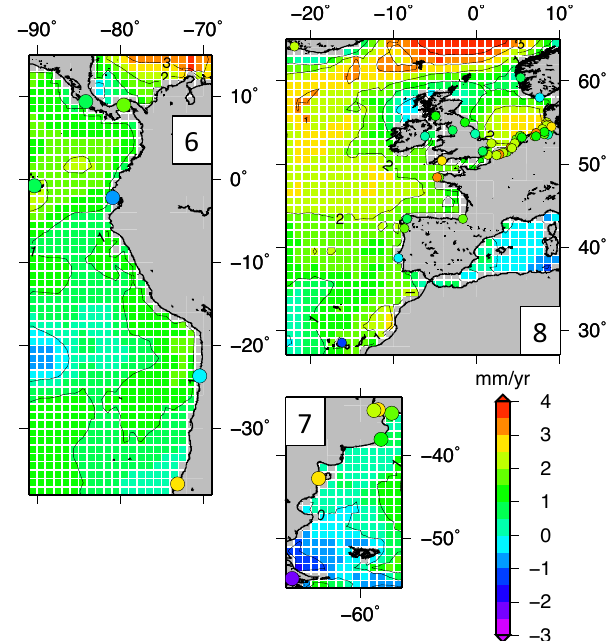
Figure 6. Trends in sea-level change (mmyr − 1 ) over the period 1961–2003, for regions (6) South American west coast, (7) South American east coast, and (8) European coast. Zoom of Fig. 4. Re- gions indicated in Fig. 1.